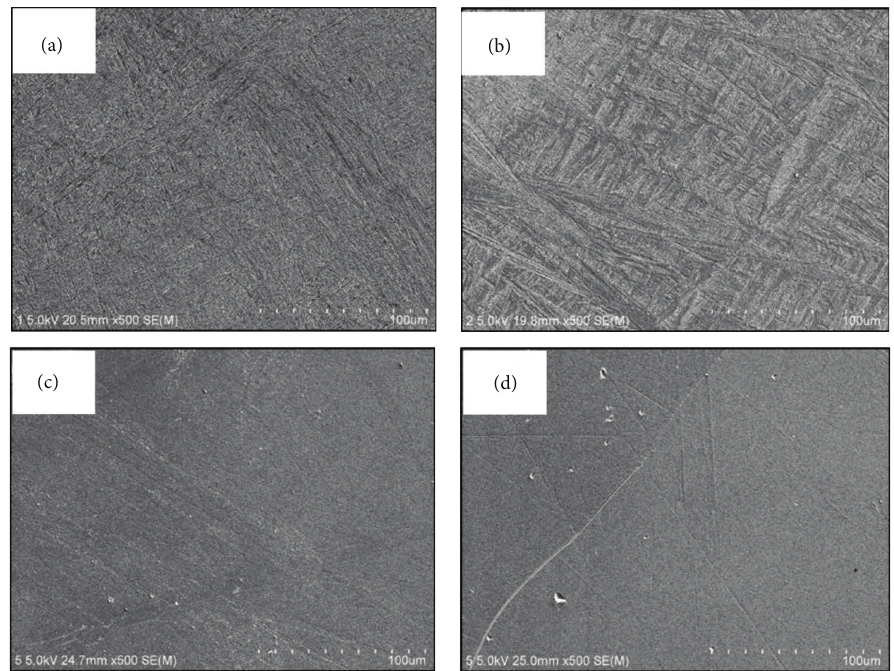
Figure 1: SEM micrographs showing the microstructures of the Ti-xMo alloys: (a) Ti-3Mo, (b) Ti-7Mo, (c) Ti-10Mo, and (d) Ti-15Mo.